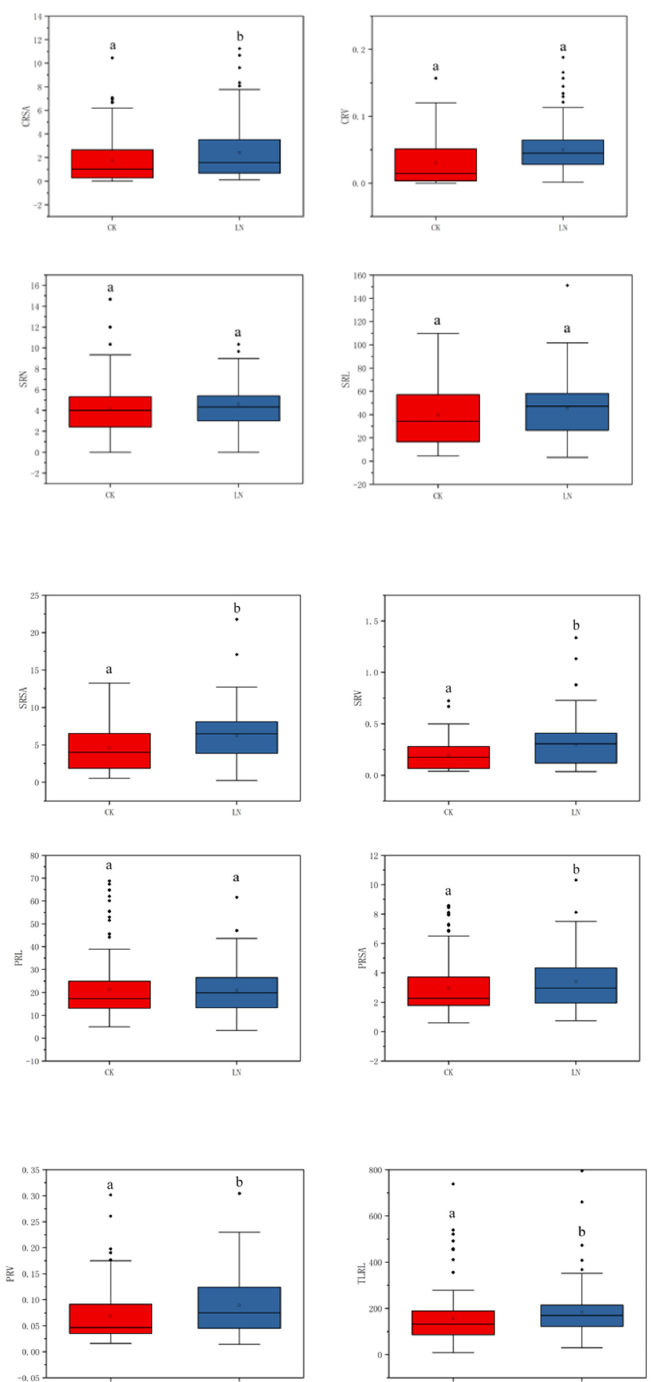
Figure 1. Phenotype data box plot for different nitrogen environments. In that order: SPAD value of the second leaf; Plant height; Shoot dry weight; Root dry weight; Root-to-shoot ratio; Total root length; Total root surface area; Total root volume; Crown root number; Crown root length; Crown root surface area; Crown root volume; Seminal root number; Seminal root length; Seminal root surface area; Seminal root volume; Primary root length; Primary root surface area; Primary root volume; Total lateral root length. In the Figure, the upper edge of the boxplot represents the maximum value; the lower edge represents the minimum value; the open circles represent the mean; the filled circles represent outliers and contains a line representing the median. a and b indicate the significance between CK and LN ( p < 0.05). Red represents CK, blue represents